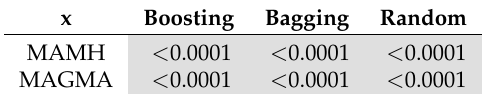
Table 8. Post-hoc Nemenyi tests for classical ensemble techniques.